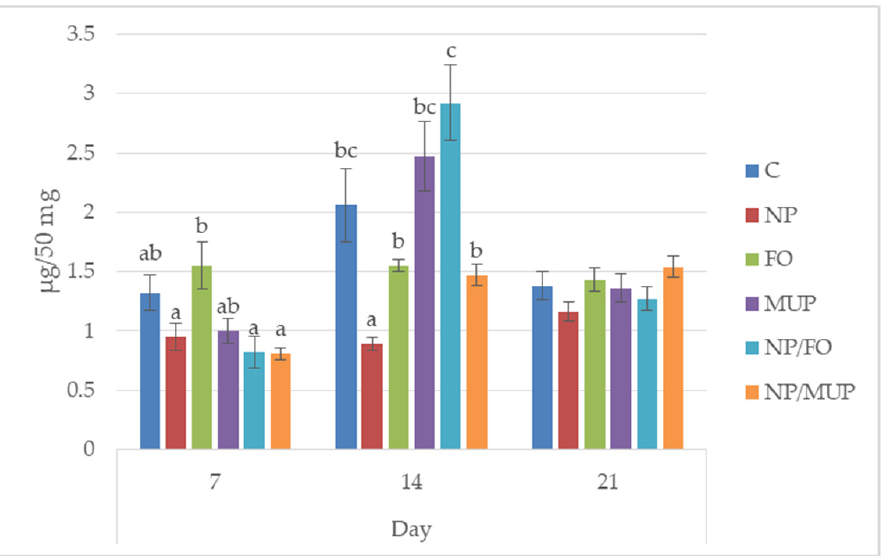
Figure 2. Hydroxyproline content in the wound in the course of healing (7, 14 and 21 days post- excision). C—control (dressing alone); NP—dressing with empty poly(lactic-co-glycolic) acid (PLGA)- polyvinyl alcohol (PVA) nanoparticles (NPs); FO—dressing with fish oil; MUP—dressing with mupirocin; NP/FO—dressing with PLGA-PVA NPs with entrapped fish oil; NP/MUP—dressing with PLGA-PVA NPs with entrapped mupirocin. Mean ± SEM. a–c: means with different superscripts within a given time interval differed significantly ( p < 0.05). One-way analysis of the variance ratio test with Tukey’s post hoc test .